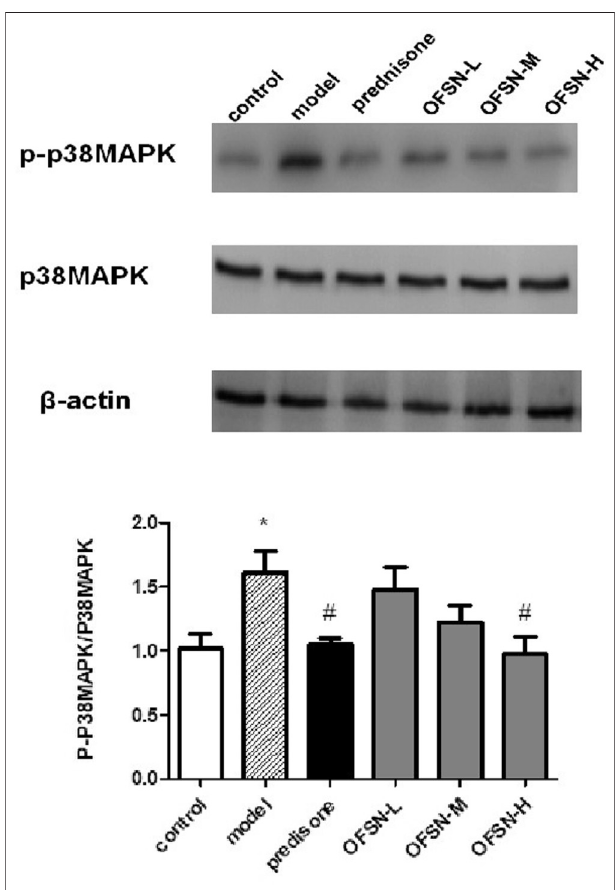
FIGURE 6 | Effects of OFSN on p-p38MAPK/p38MAPK expression in liver tissues. Data are mean ± SD; * p < 0.05 vs. control group; # p < 0.05 vs. model